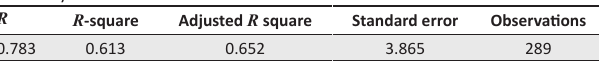
TABLE 4: Strategy formulation and short-term financial performance model summary. R